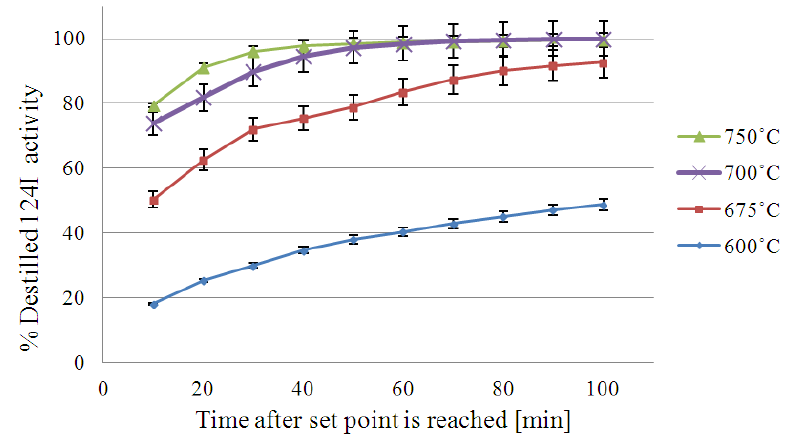
Figure 3. Graph showing the percent 124 I distilled as a function of time. The first collection tube was mounted at room temperature and changed 10 min after the set temperature was